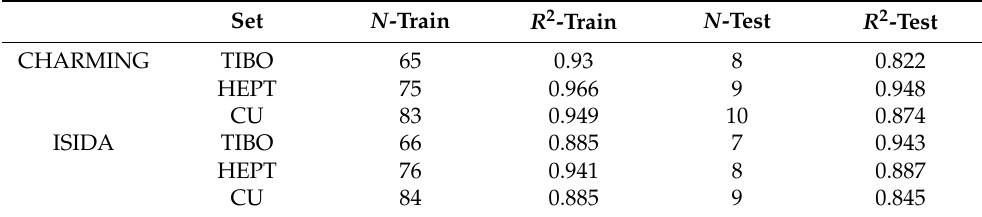
Table 4. Statistical parameters calculated for each model in the prediction of anti-HIV activity for three different groups of molecules: cyclic ureas (CU), TIBO, and HEPT derivatives. ISIDA results were executed by Vernek’s group [43]. For further details see Supplementary